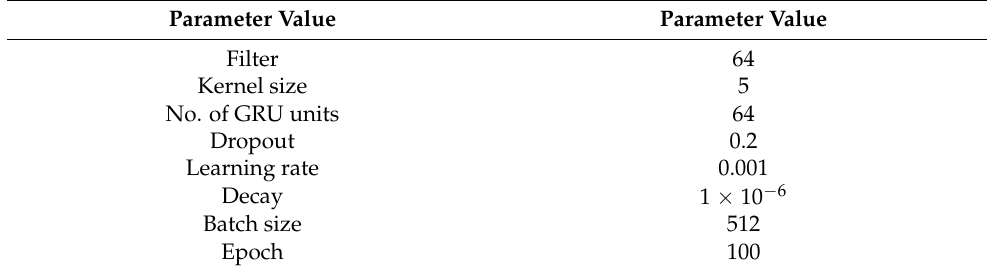
Table 1. Parameter tuning of the 1D CNN-GRU